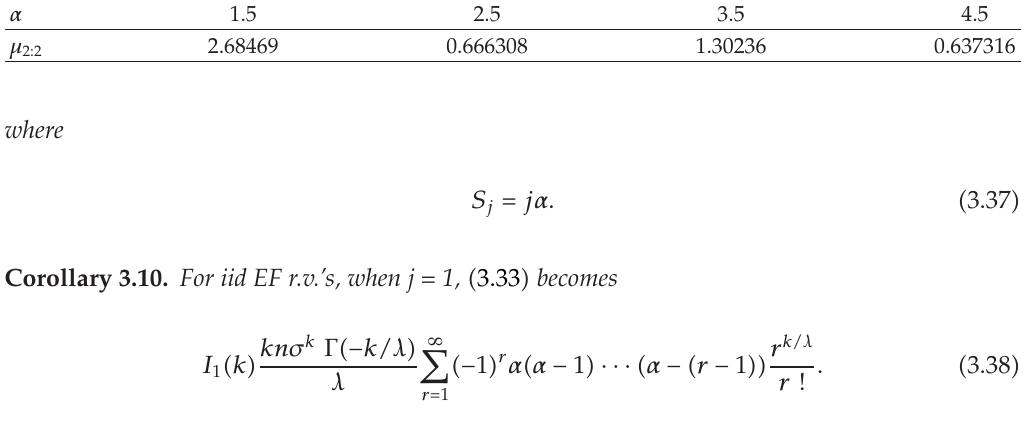
Table 5: The moments μ 2:2 arising from IID Exponentiated Frechet r.v.’s. using (cid:2) 3.29 (cid:3) or (cid:2) 3.31 (cid:3) .